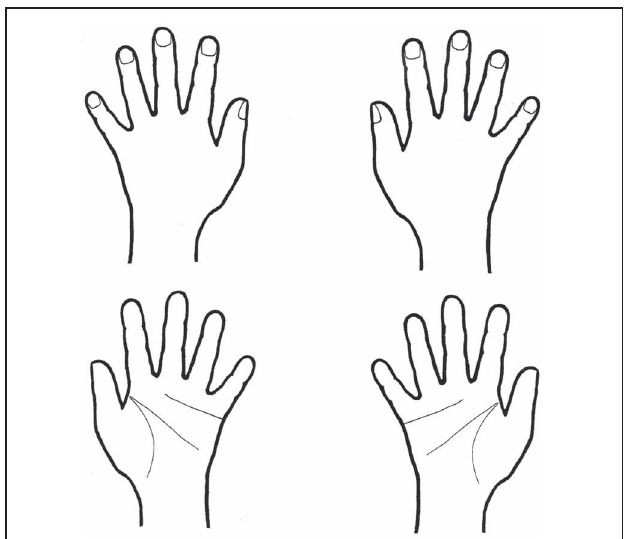
FIGURE 1 | Examples of hand stimuli. The schematic drawing could depict the palm or the back of a left or a right hand. Hands were shown as single stimulus (see Materials and